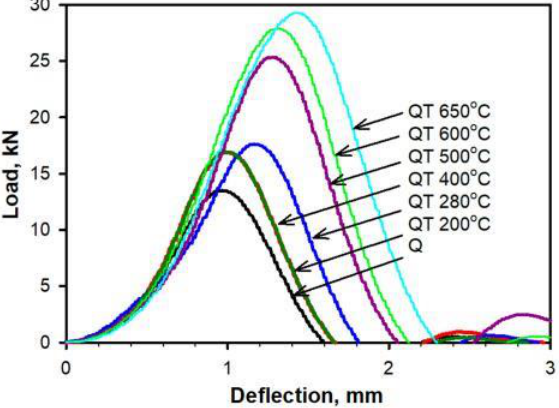
Figure 4. Load vs. deflection dependencies at room temperatures of the 0.4%C-1.6%Si-1%Cr-0.95%Mo steel with V and Nb after quenching (Q) and different tempering (T) temperatures.